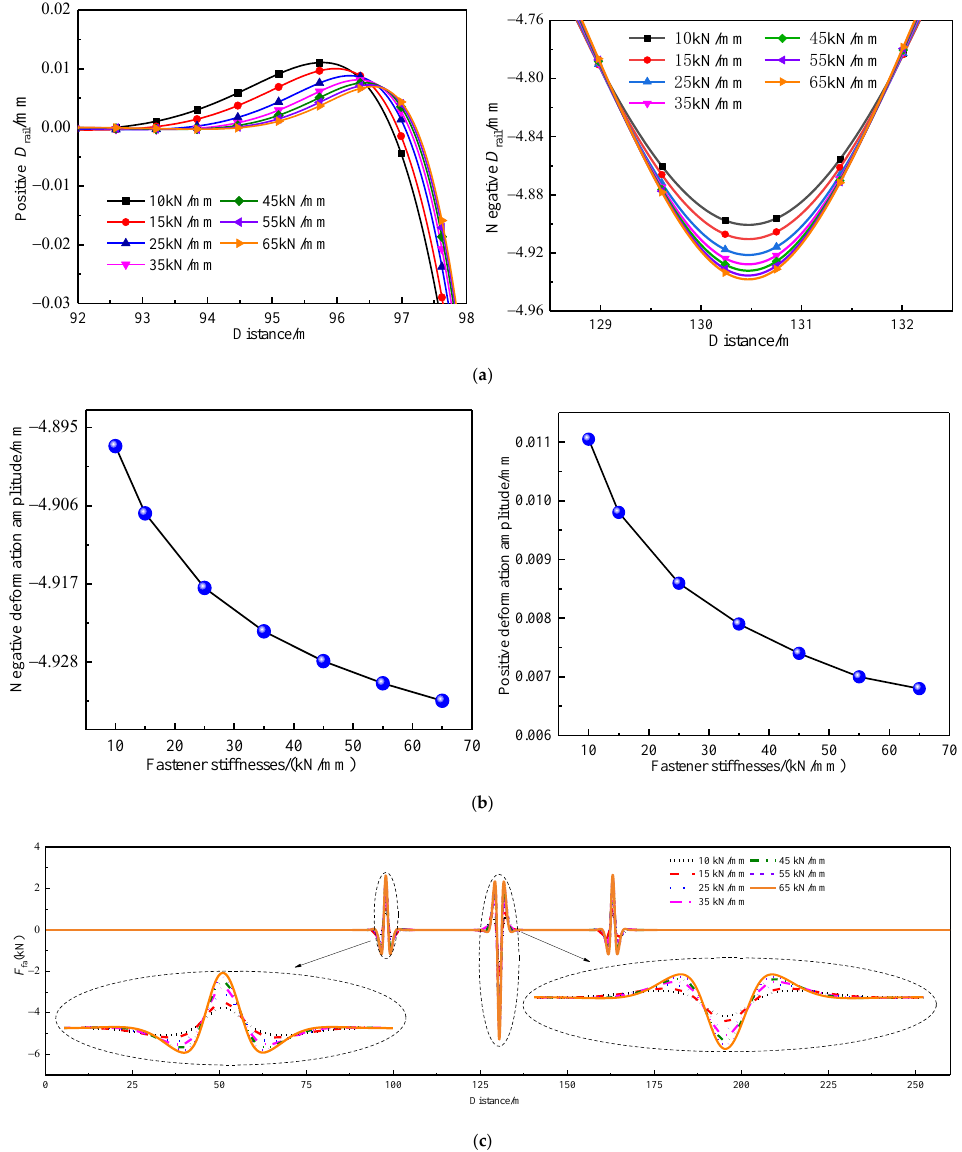
Figure 11. The influence of fastener stiffness. ( a ) Mapping deformation of the rail under different fastener stiffnesses; ( b ) mapping deformation amplitude of the rail under different fastener stiffnesses; and ( c ) fastener force under different fastener stiffnesses.